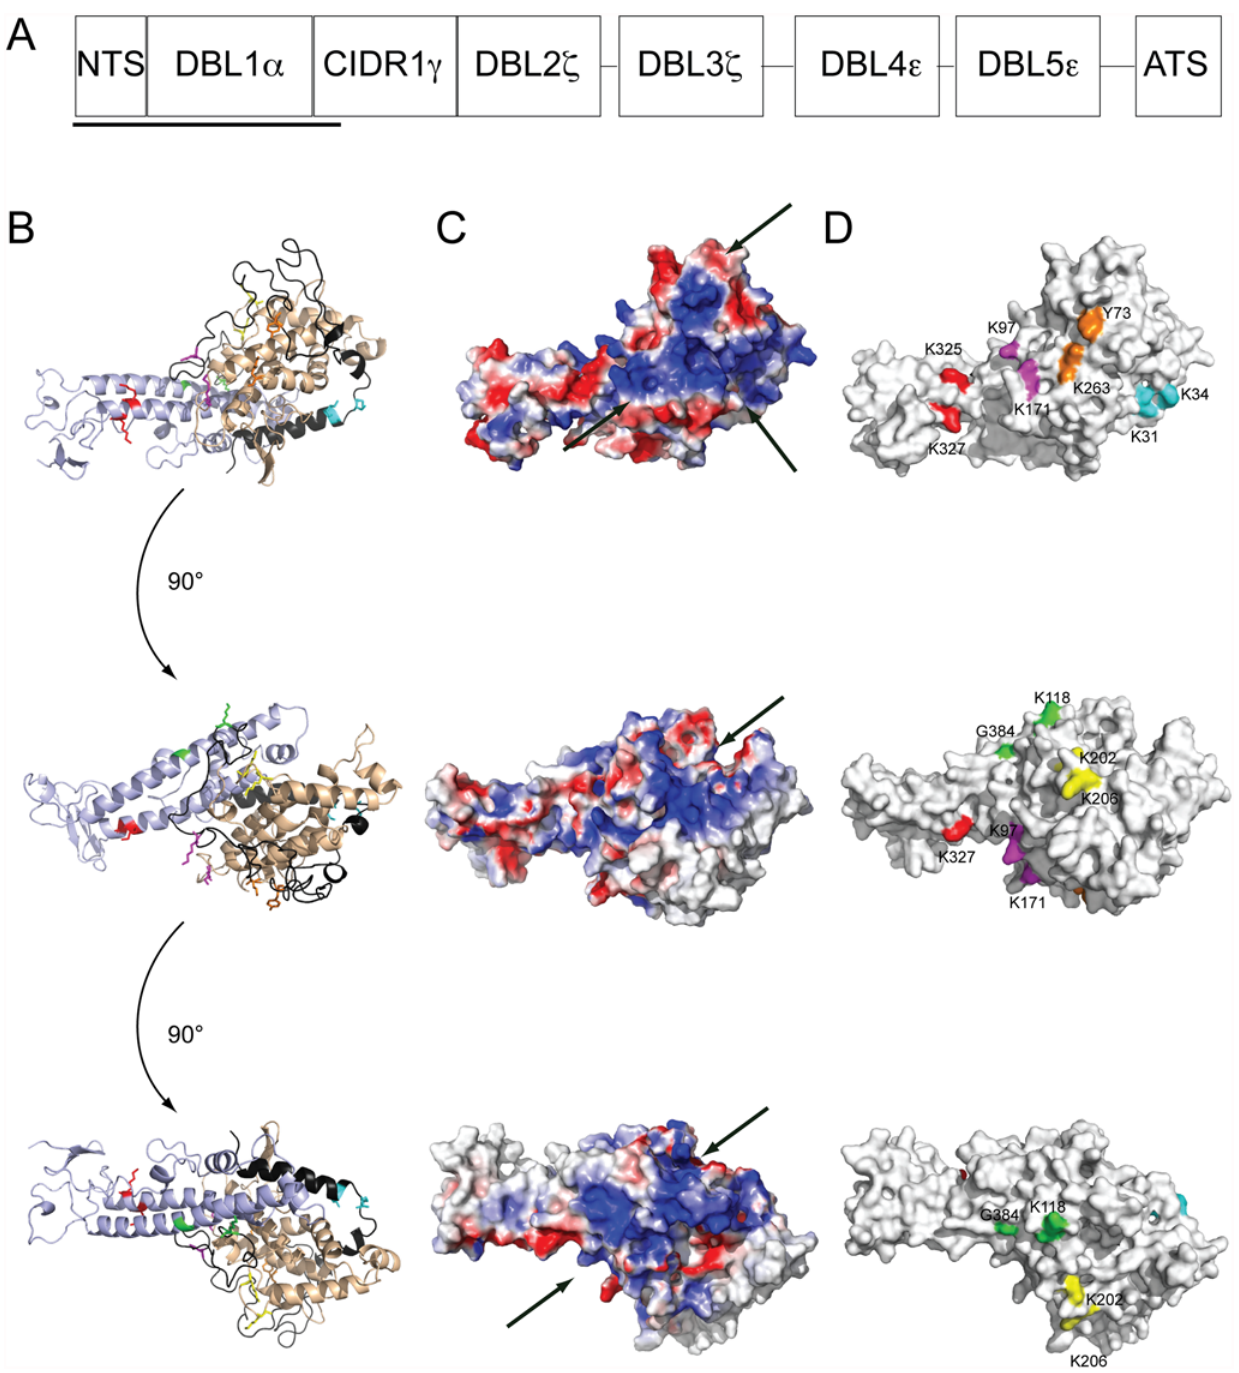
Fig 1. Localization of selected mutations on the protein molecular model. A) Domain organization of the IT4var60 PfEMP1 protein with underlined the construct used in this study. B) A molecular model of the NTS-DBL1 α of IT4var60 was built based on the crystal structure of the NTS-DBL1 α domain of PAvarO strain (PDB: 2yk0) [21]. Three 90 degrees orthogonal views of the molecule in the cartoon representation with mutated amino acids depicted in color. Subdomains 1, 2 and 3 are colored in black, light brown and light blue, respectively. C) Three 90 degrees orthogonal views of the molecule surface in the surface charge potential representation. Arrows indicate positively charged patches Blue: positive charge; white neutral charge; red: negative charge. D) Three 90 degrees orthogonal views of the molecule in the surface representation with mutated amino acids depicted in color. Mut A (Y73A, K263E): orange; Mut B (K118E, G384H): green; Mut C (K202A, K206A): yellow; Mut D (K97A, K171A): purple; Mut E (K325A, K327A): red; Mut F (K97A): black; Mut G (K263E): blue; Mut H (K31A, K34A): cyan.